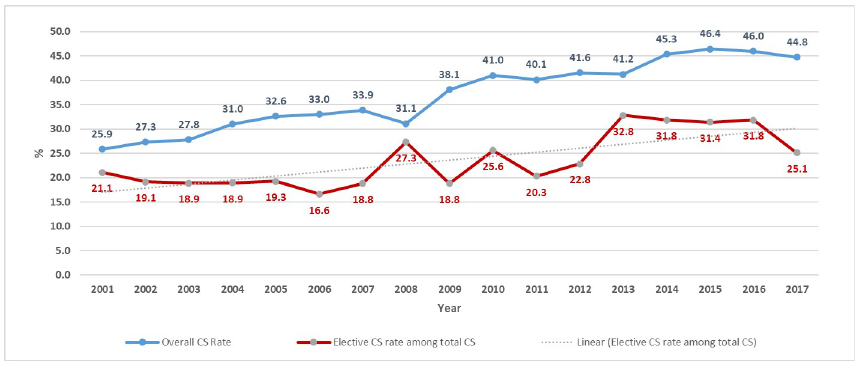
Fig 2. Trends of CS and elective CS between 2001 and 2017.